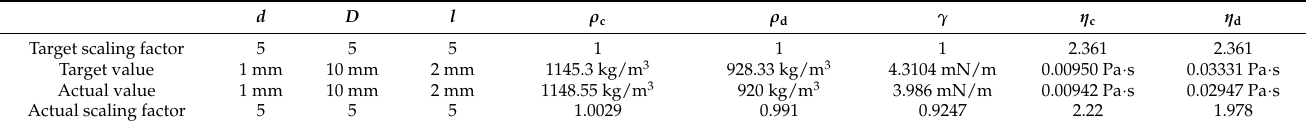
Table 3. Resulting scaling factors, material properties and dimensions of the Ψ = 5 system. d